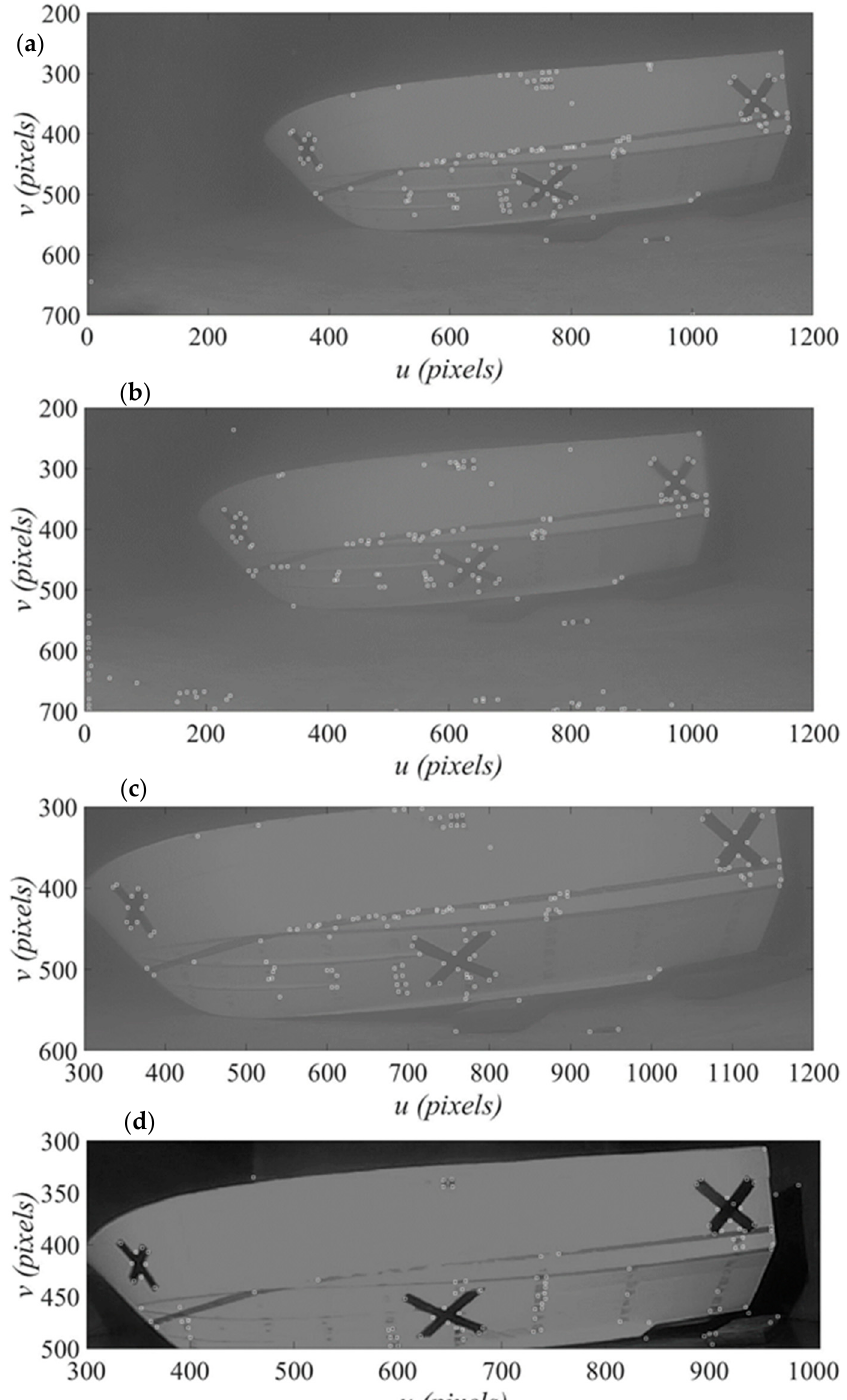
Figure 24. Results of ( a ) left and ( b ) right images; and partial enlargement of ( c ) left and ( d ) right images from Harris corner detection on the ship model in the underwater environment.